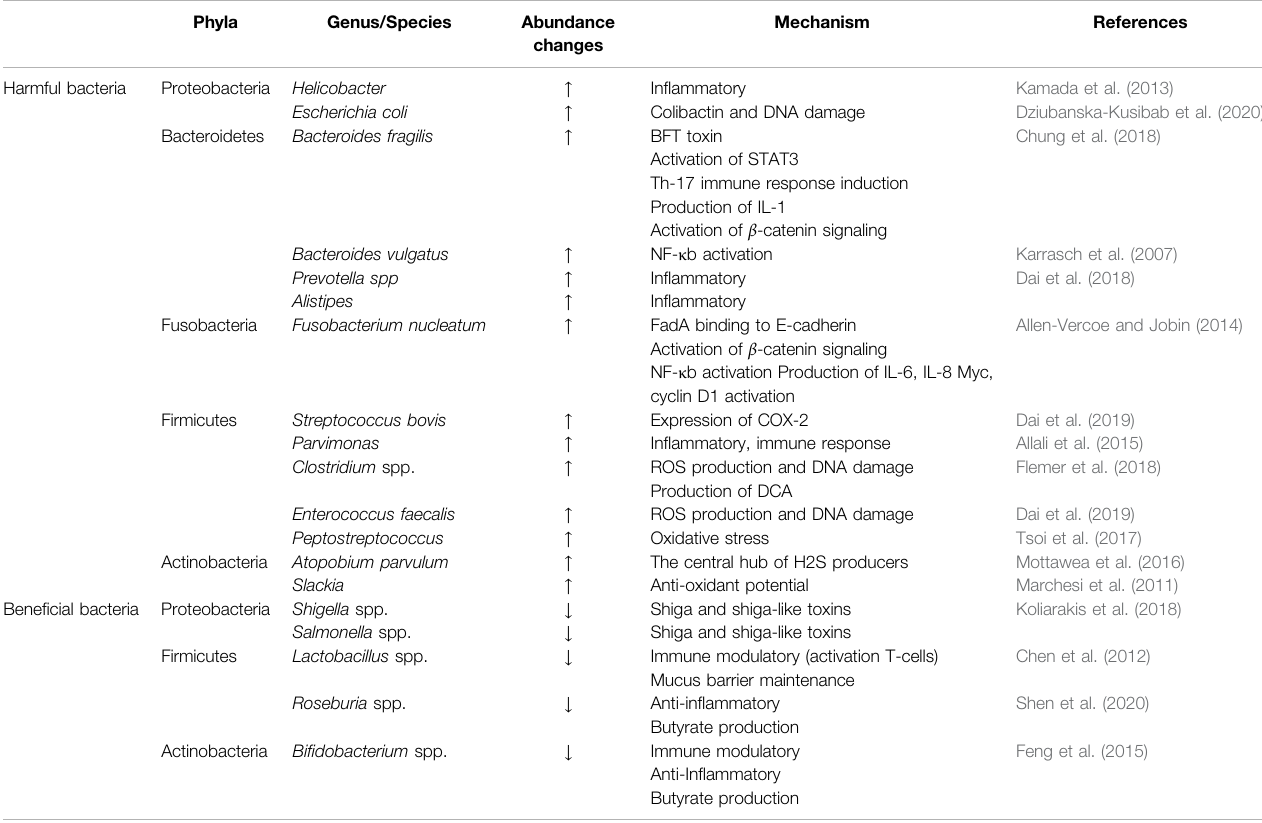
TABLE 1 | Summary of harmful and bene fi cial bacteria in colorectal